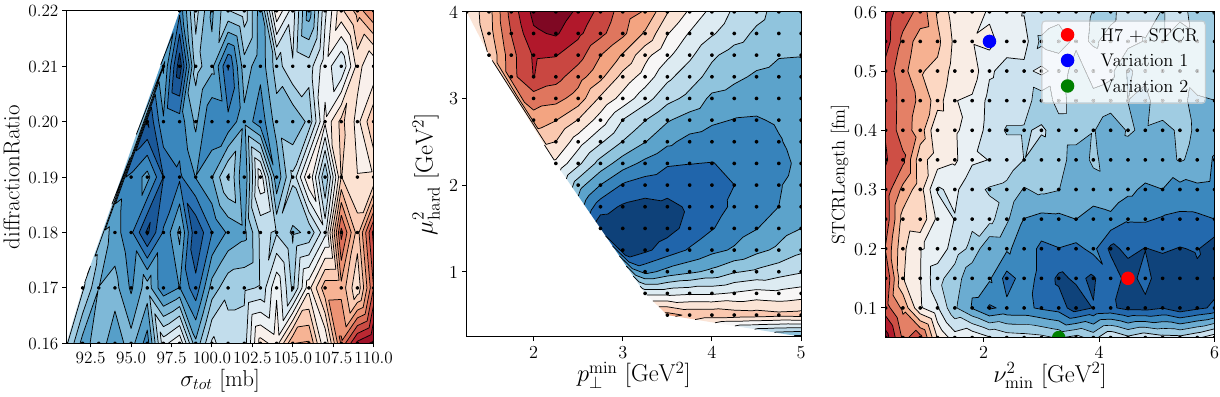
Fig. 8 χ 2 -planes for parameter sets ( R Diff , σ tot ), ( μ 2 , p min ⊥ ) and ( ν 2 , d 0 ). Bluer areas in the χ 2 contour plots correspond to smaller χ 2 values. hard In the right plot we pick three parameter pairs to define variations to be shown in the data comparison, see Figs. 9, 10, 11 and 12